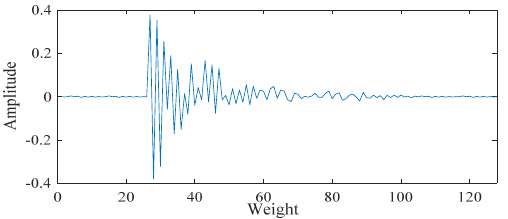
Figure 12. Impulse response of the echo path.